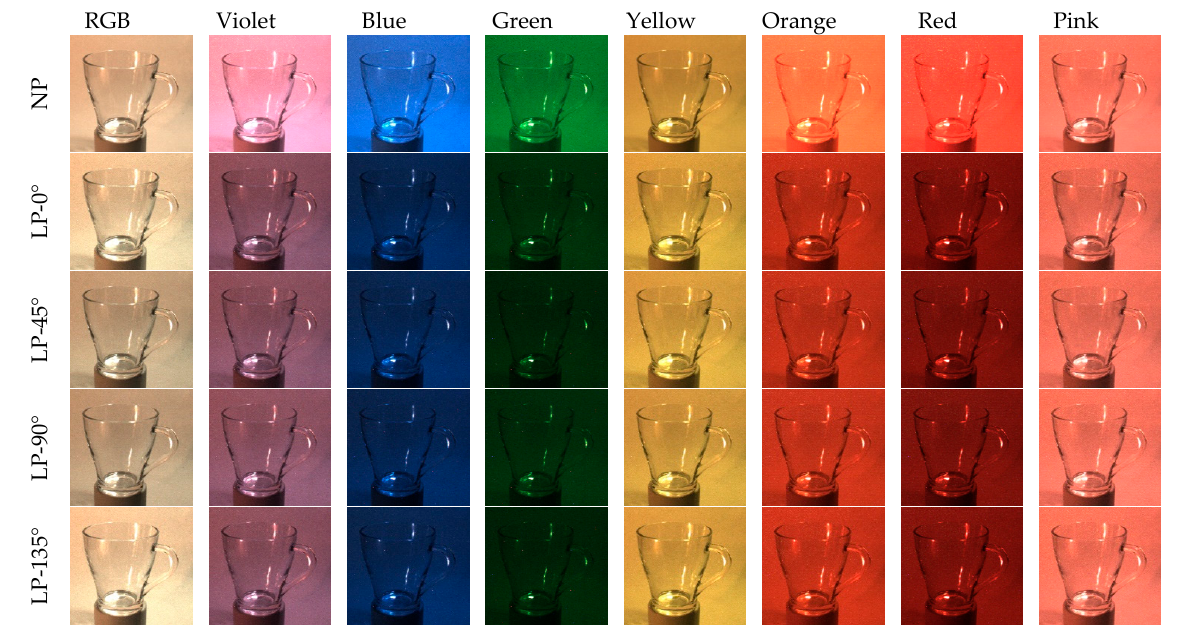
Figure 3. Multiband polarimetric images of object O#8 (seven individual bands and RGB band in visible range (400 nm–700 nm) at four polarimetric orientations (0 ◦ , 45 ◦ , 90 ◦ , and 135 ◦ ) with no polarization setting).